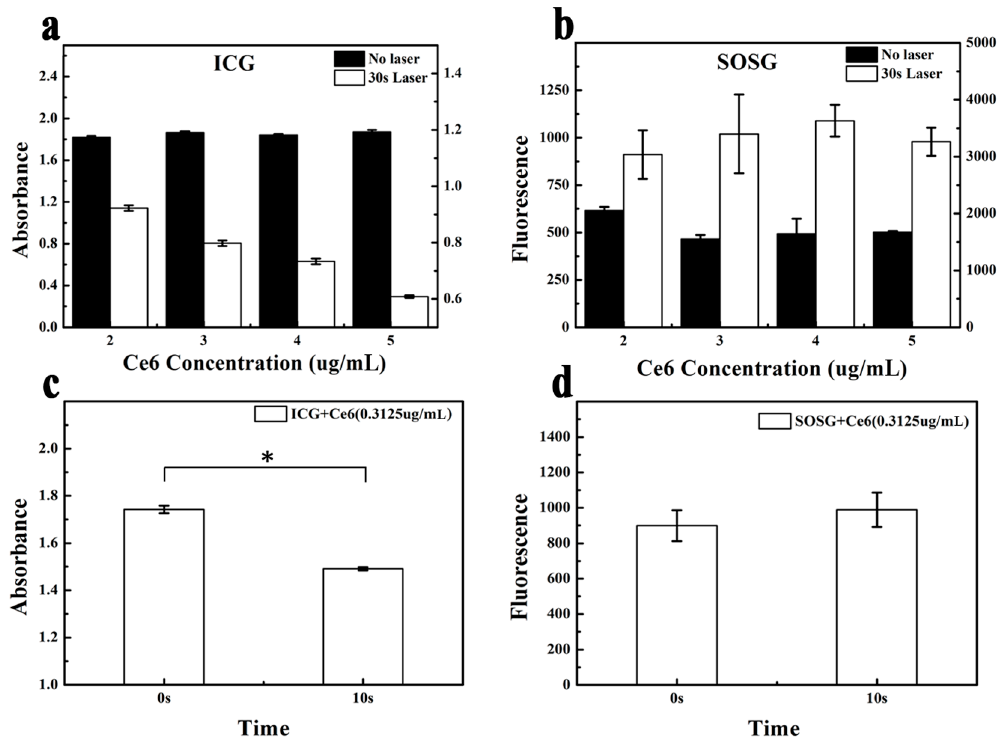
Figure 3. Accuracy of ICG to detect 1 O 2 . ( a ) UV absorbance of ICG with different Ce6 concentrations after 30 s laser irradiation (*, p < 0.05); ( b ) fluorescence intensity of SOSG with different Ce6 concentrations after 30 s laser irradiation; ( c ) absorbance of ICG with the lowest Ce6 concentration after 10 s laser irradiation (*, p < 0.05); ( d ) fluorescence intensity of SOSG with the lowest Ce6 concentration after 10 s of laser irradiation. (Mean ± SD, n = 3)